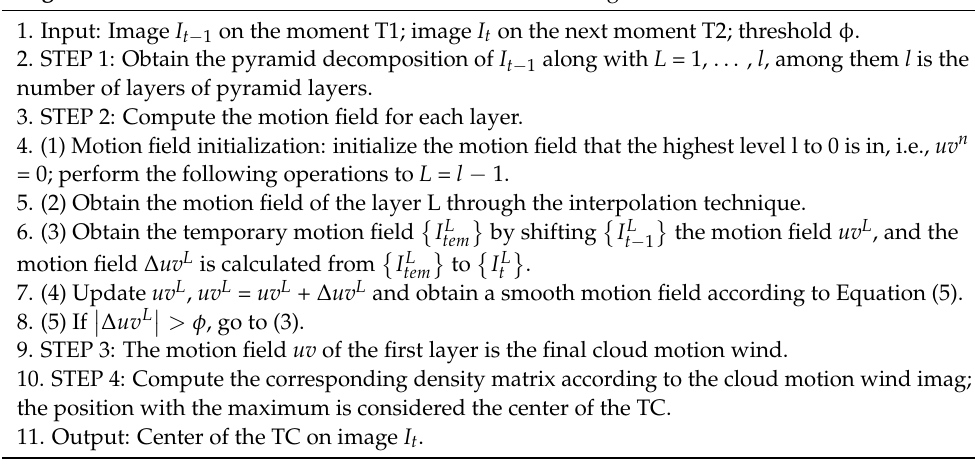
Algorithm 1 Cloud Motion Wind Based TC Center